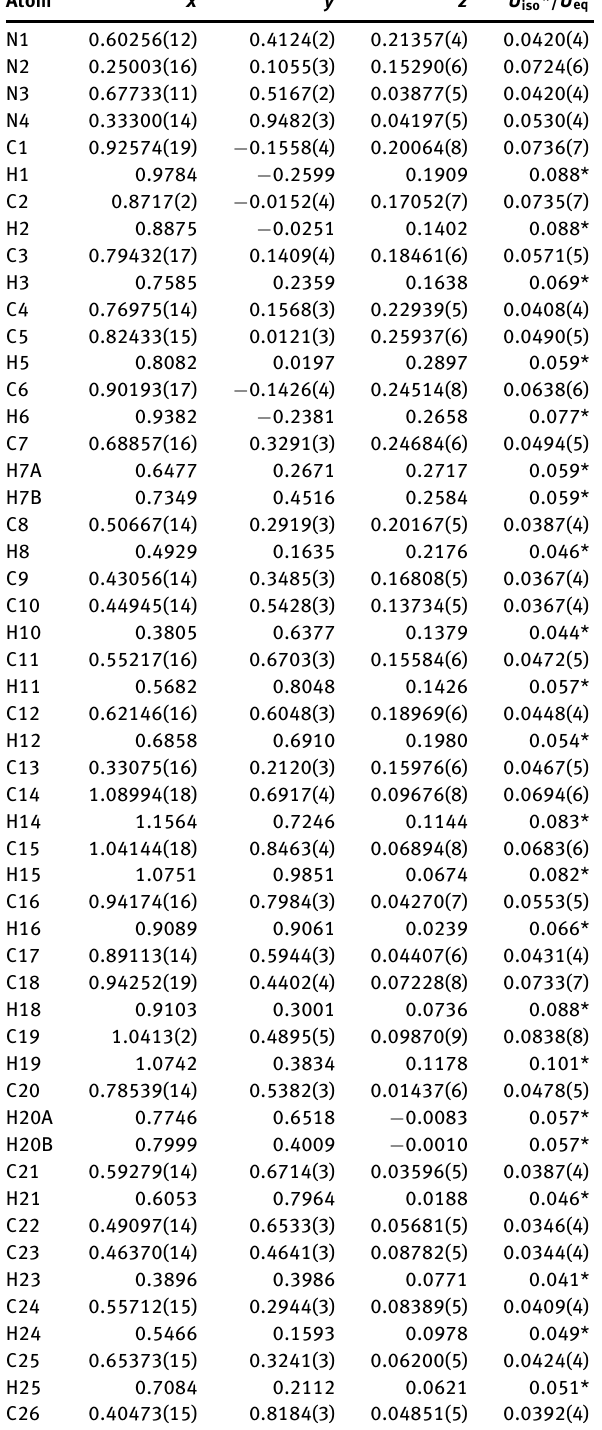
Table 2: Fractional atomic coordinates and isotropic or equivalent isotropic displacement parameters (Å 2